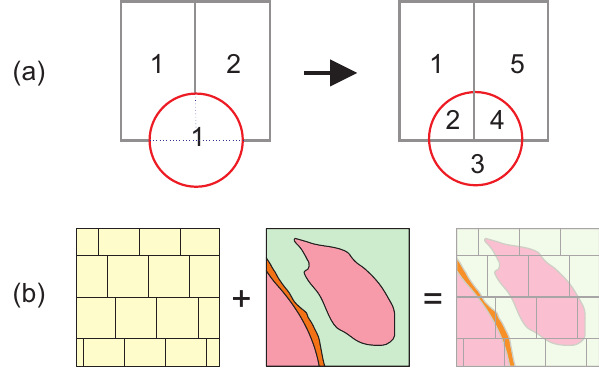
Fig. 7. The process of unioning: (a) We illustrate the union process with two rectangles in the first layer and one circle in the second layer. Following union the resultant layer, in this case, has 5 poly- gons, none of which are circular or rectangular. We note that the number of polygon features in the output layer is greater than the number of polygons in either input layer. Any polygon on either input layer can be made up from a number of polygons in the out- put layer. The resultant layer has the attributes of both input layer polygons in its attribute table; (b) a schematic of how the process would look for the grid and geology